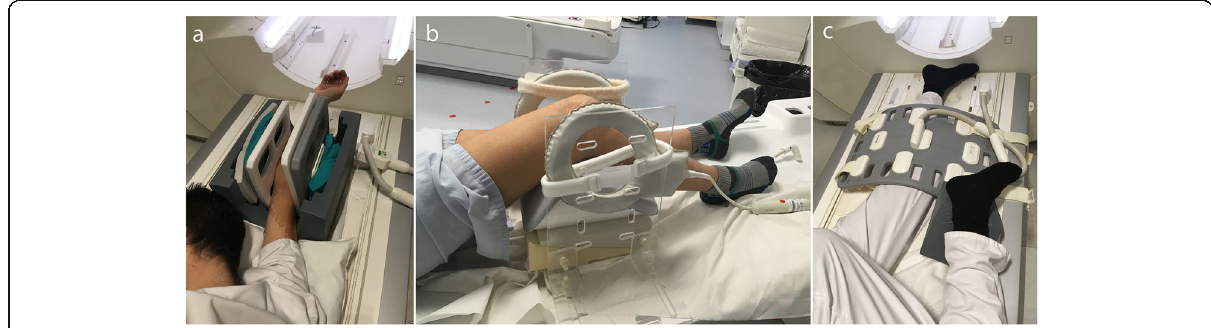
Fig. 6 Patient and flex coil positioning for elbow ( a ) and knee motion evaluation ( b , c ). The flex coil is held by a dedicated support in an Avanto fit 1.5 T Siemens MRI scanner for elbow motion evaluation ( a ). The patient is positioned supine with a homemade support for coil positioning in an Achieva dStream 3.0 T Philips MRI scanner ( b ) or lateral decubitus in an Avanto fit 1.5 T Siemens MRI scanner ( c ) for knee motion